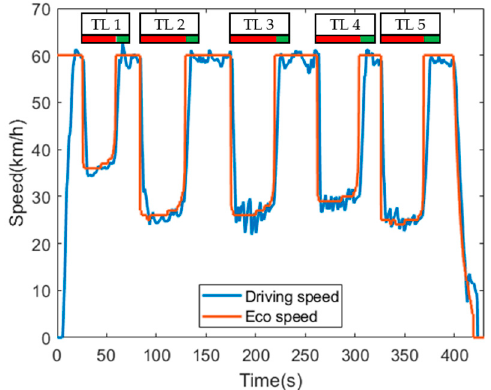
Figure 8. Driving speed of normal HEV.